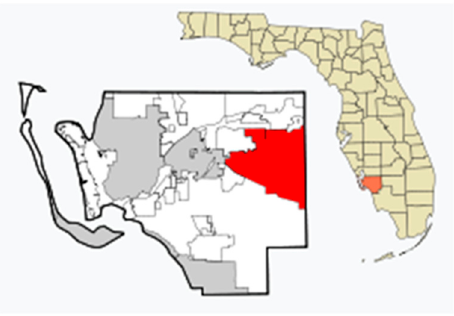
Figure 2. Map showing the location of Lehigh Acres in Lee County, Florida. The total area shown in red is about 249 km 2 .